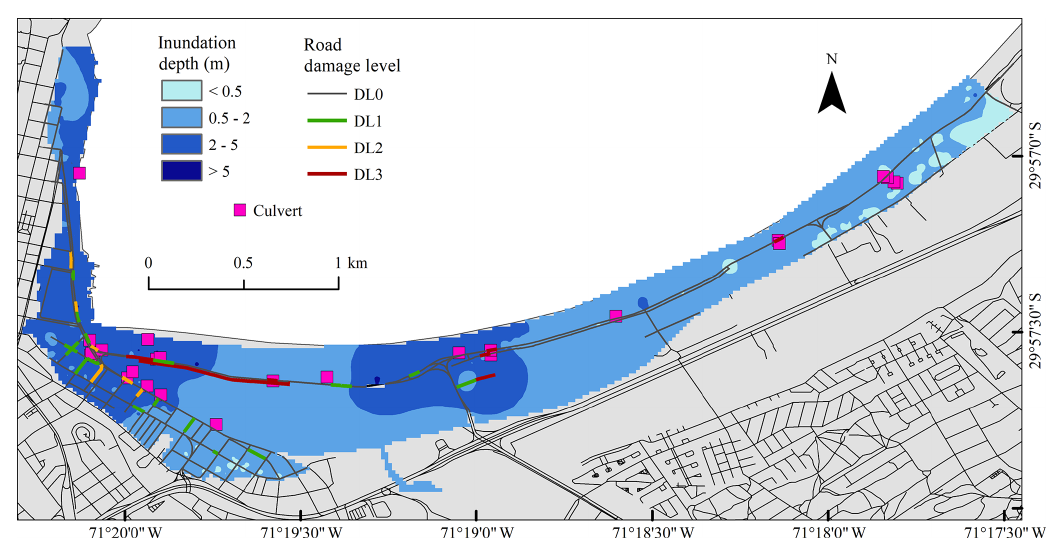
Figure 2. Tsunami inundation, road damage level and culvert locations in Coquimbo, Chile, following the 2015 Illapel earthquake